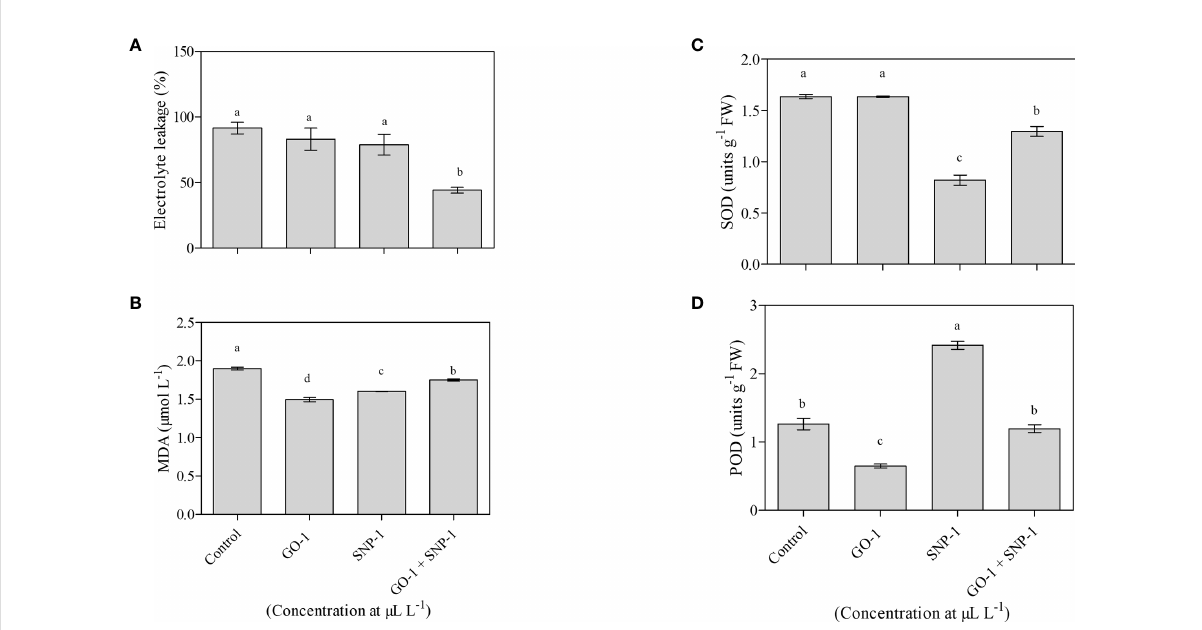
FIGURE 5 Effect of NPs (A) Control, (B) GO at 1 µL L − 1, (C) SNP 1 µL L − 1 , and (D) GO + SNP 1 µL L − 1 on (A) Electrolyte leakage, (B) MDA, (C) SOD activity, and (D) POD activity in the petals of bird of paradise cut fl owers. The samples were collected at day 12. Each data point indicates mean of three independent biological replicates. Error bars indicate SE of mean. Means with different letters are signi fi cantly different (Duncan ’ s multiple range test, p = 0.05